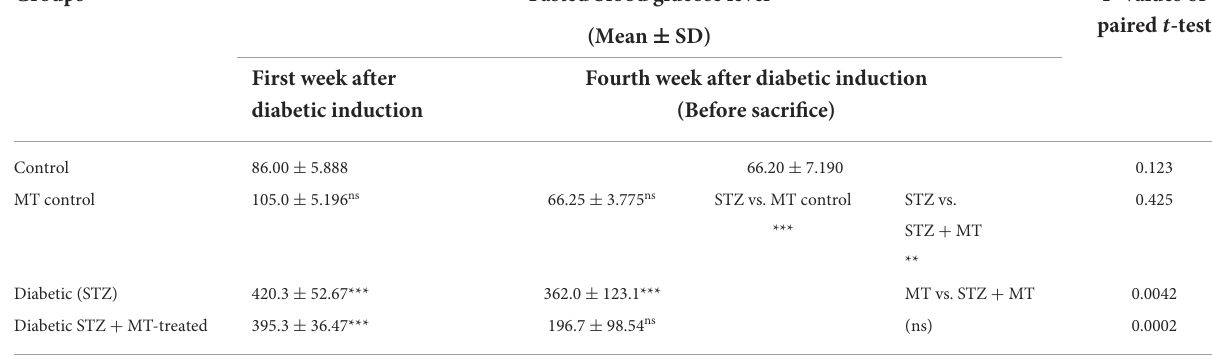
TABLE 2 Comparison of fasting blood glucose levels in the experimental groups.